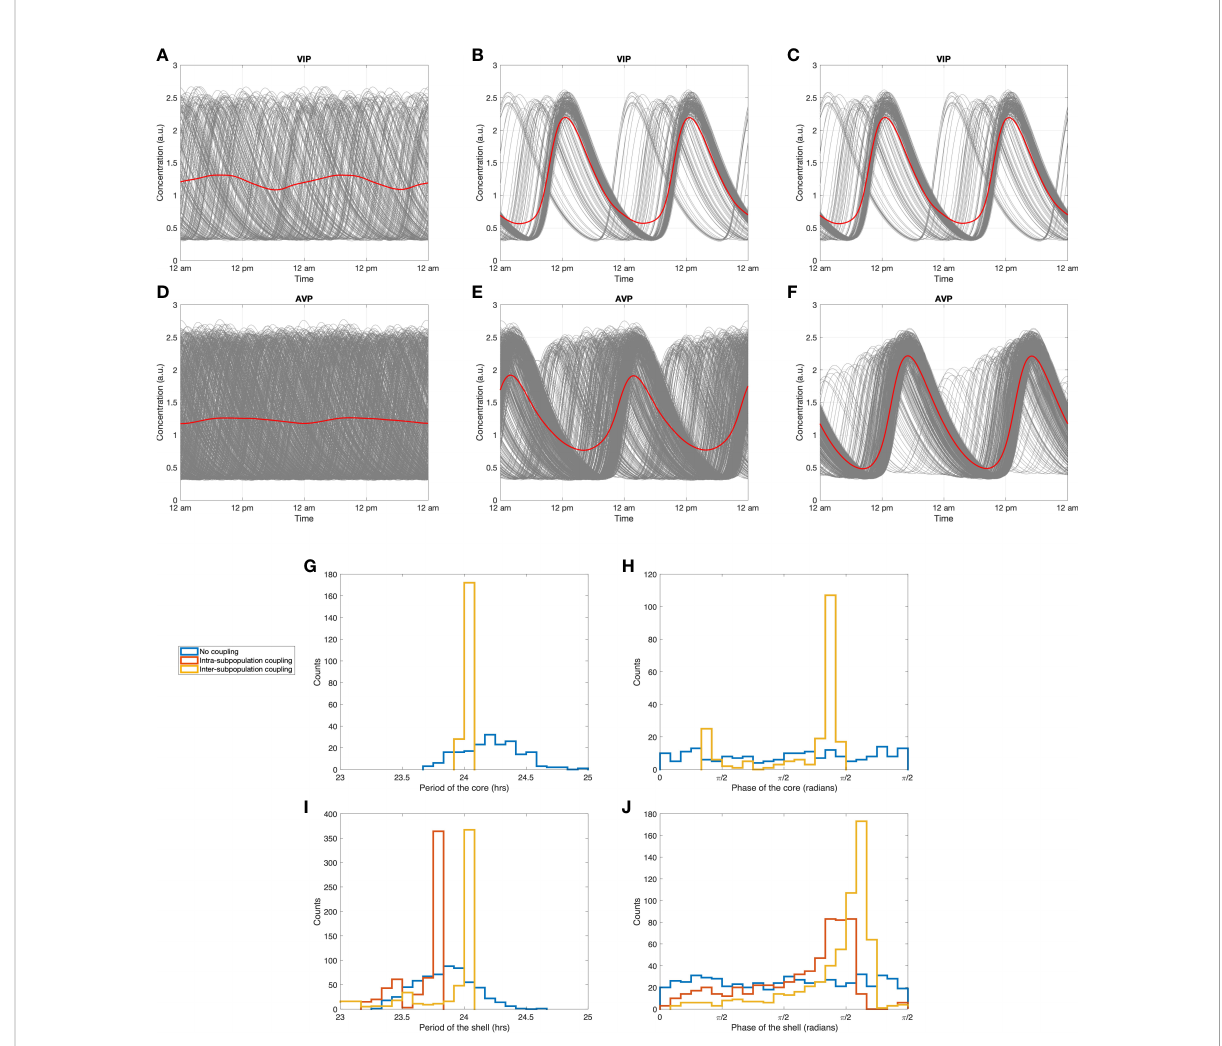
FIGURE 6 Synchronization dynamics of the SCN during constant darkness. Circadian dynamics of VIP (A) without any inter-neuronal coupling, (B) with intra- subpopulation coupling, (C) with intra-subpopulation and inter-subpopulation coupling (with probability P PT =0.3 ). Circadian dynamics of AVP (D) without any inter-neuronal coupling, (E) with intra-subpopulation coupling, (F) with intra-subpopulation and inter-subpopulation coupling (with probability P PT =0.3 ). (G, I) : period distributions of the core and the shell under three coupling conditions. (H, J) : phase distribution of the core and the shell under three coupling conditions. Blue curves: distributions without any inter-neuronal coupling. Red curves: distributions with intra- subpopulation coupling. Yellow curves: distributions with both intra-subpopulation and inter-subpopulation